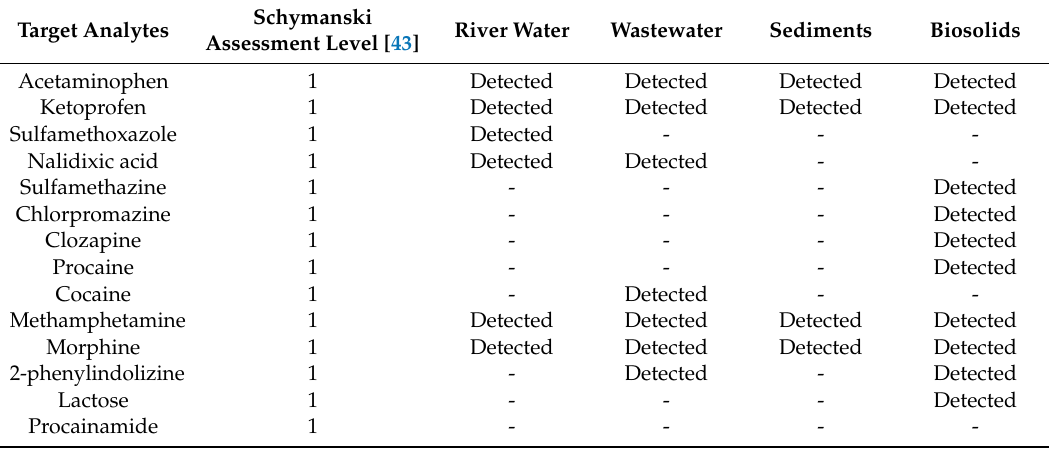
Table 5. Qualitative analysis of silylated target compounds in the Msunduzi and Mgeni